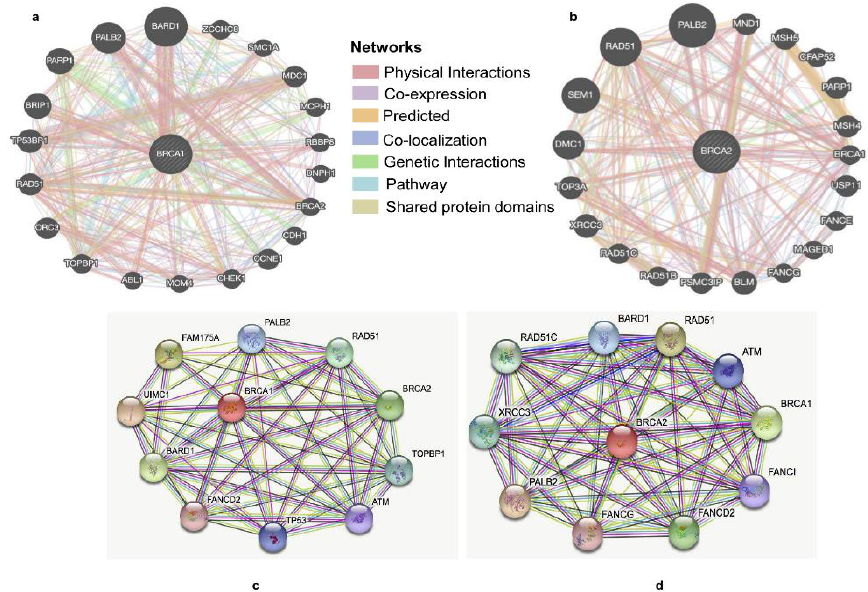
Figure 9. Identification of BRCA1/2 interacting genes and proteins. ( a,b ) The gene–gene interaction network of BRCA1/2 was constructed using GeneMania. ( c,d ) The protein–protein interaction network of BRCA1/2 was generated using STRING db.